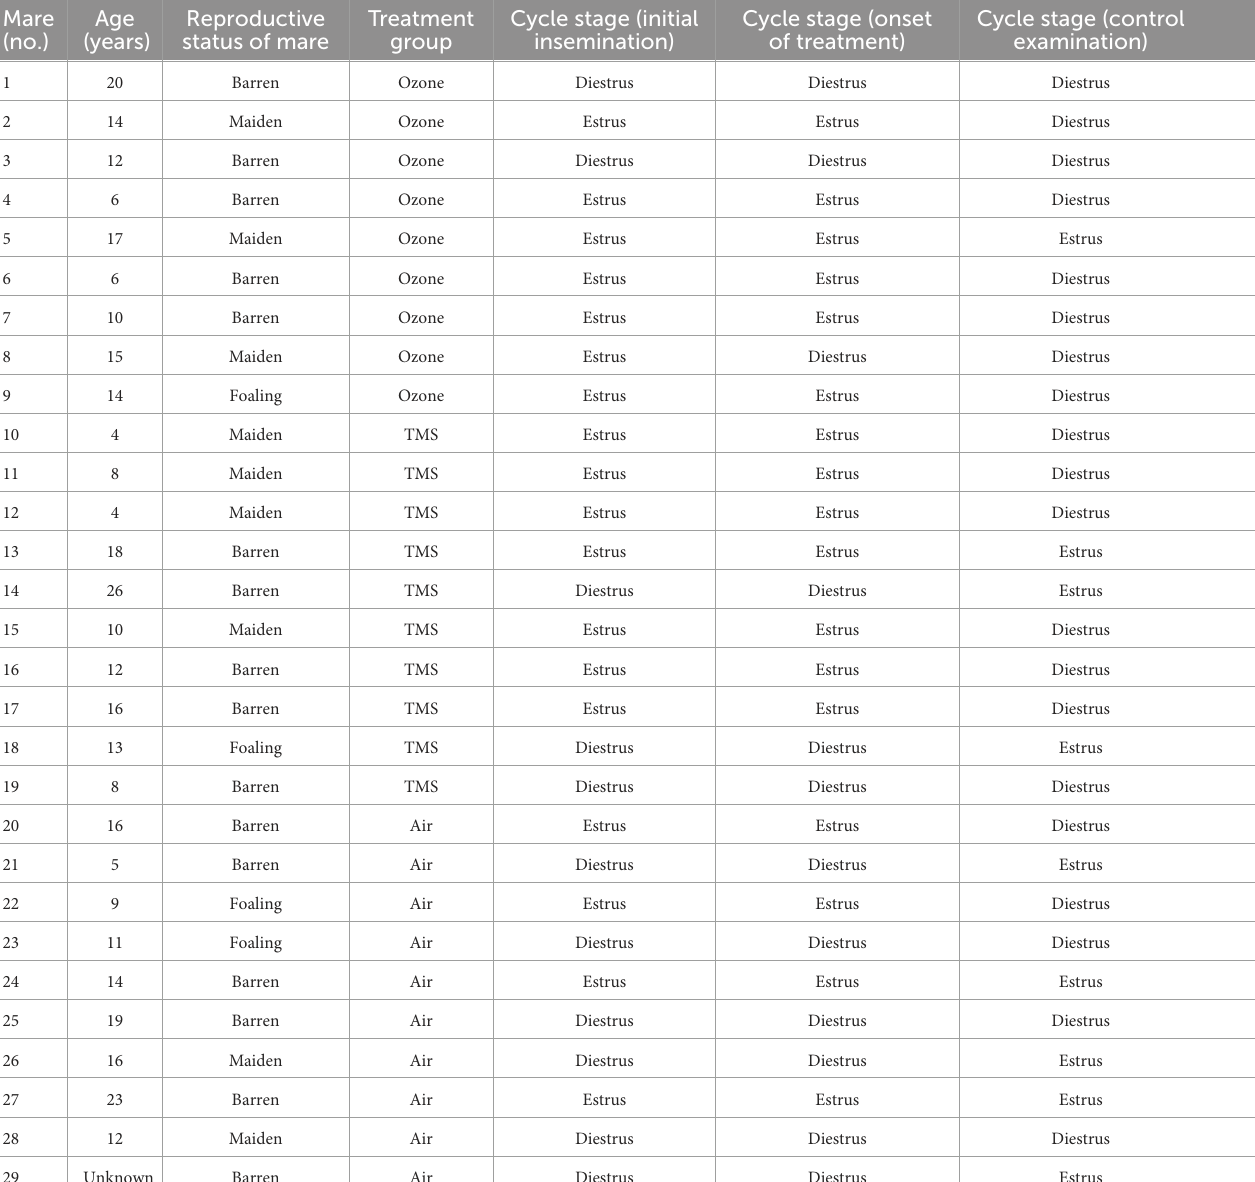
TABLE 2 Information on individual mare characteristics and cycle stage at the initial examination, the onset of treatment and control examination as determined by gynecological examination. Mare